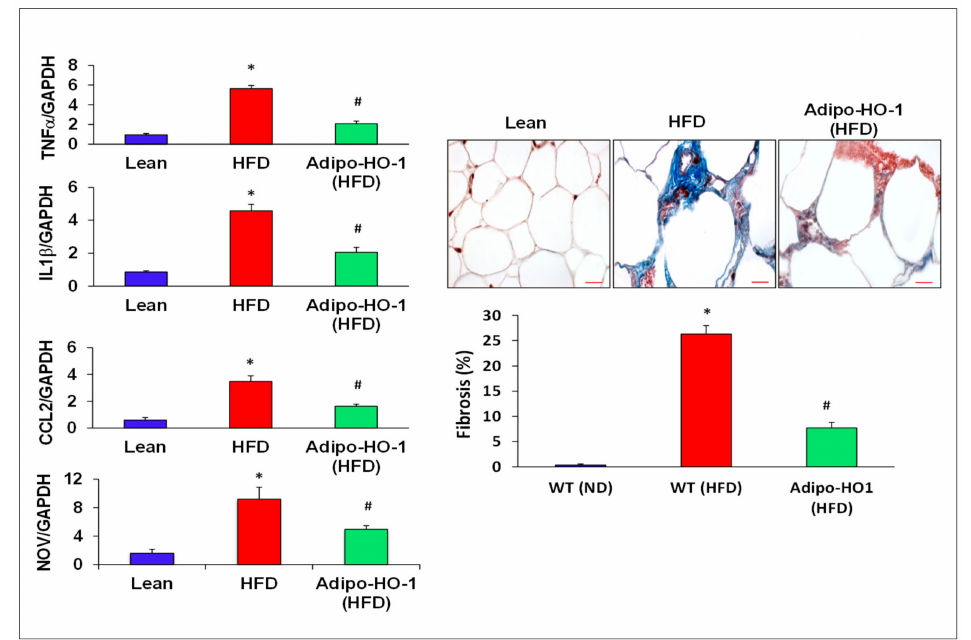
Figure 5. Expression of inflammatory mediators in adipose tissue of lean, HFD, and Lnv-adipo-HO-1 (HFD) mice. Relative mRNA levels of TNF- α , IL1 β , CCL2, and NOV, followed by histological analysis of adipose tissue fibrosis, using hematoxylin / eosin and Masson trichrome staining; n = 5, * p < 0.05 versus lean; # p < 0.05 versus HFD